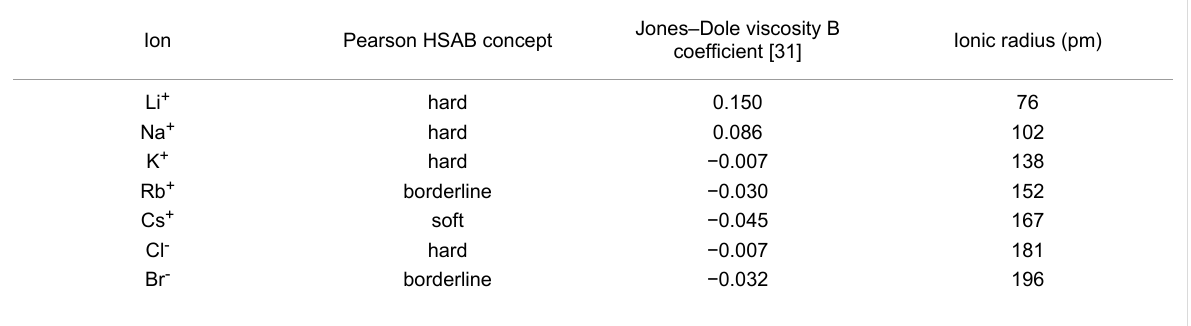
Table 3: Counter-ion partnerships.